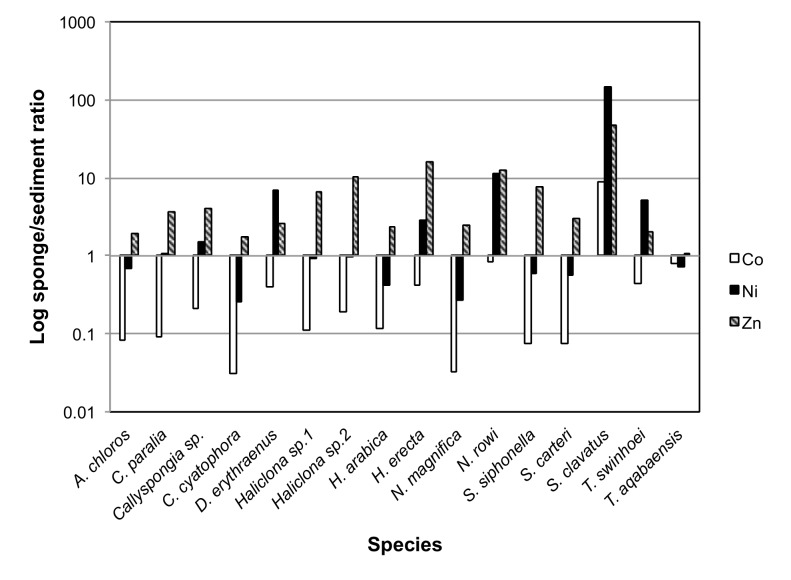
Bioconcentration factors of Co (white), Ni (black) and Zn (grey) in all sponge species compared to sediment (value set as 1).